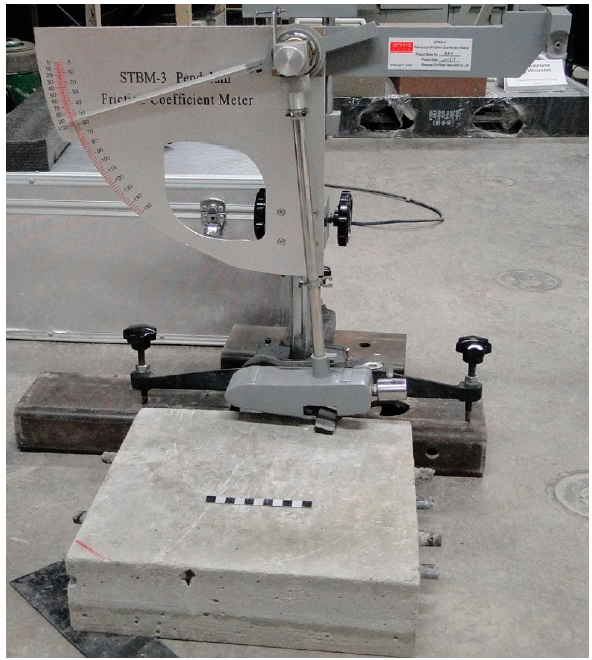
Figure 6. British Pendulum Tester and the concrete slab specimen.